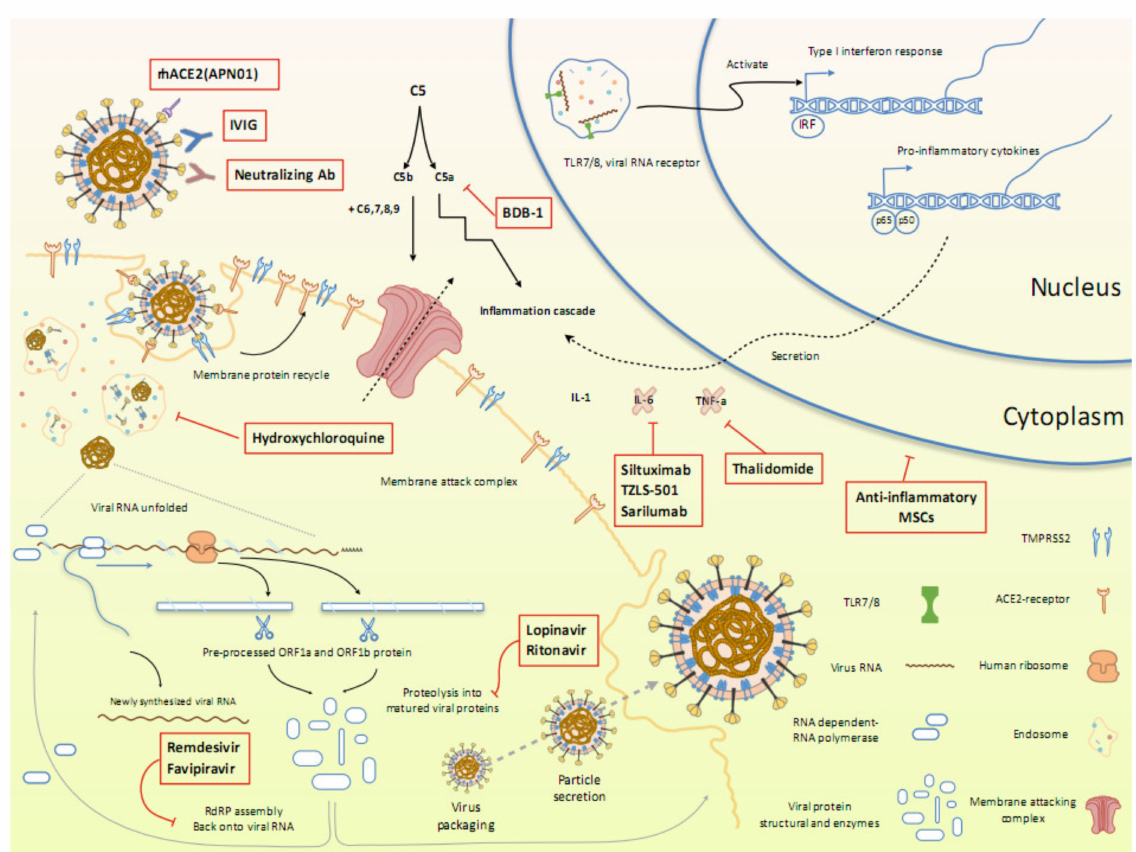
Figure 2. Overview of the repurposed therapeutic drugs undergoing clinical trial against COVID-19 in the context of host pathways and virus replication